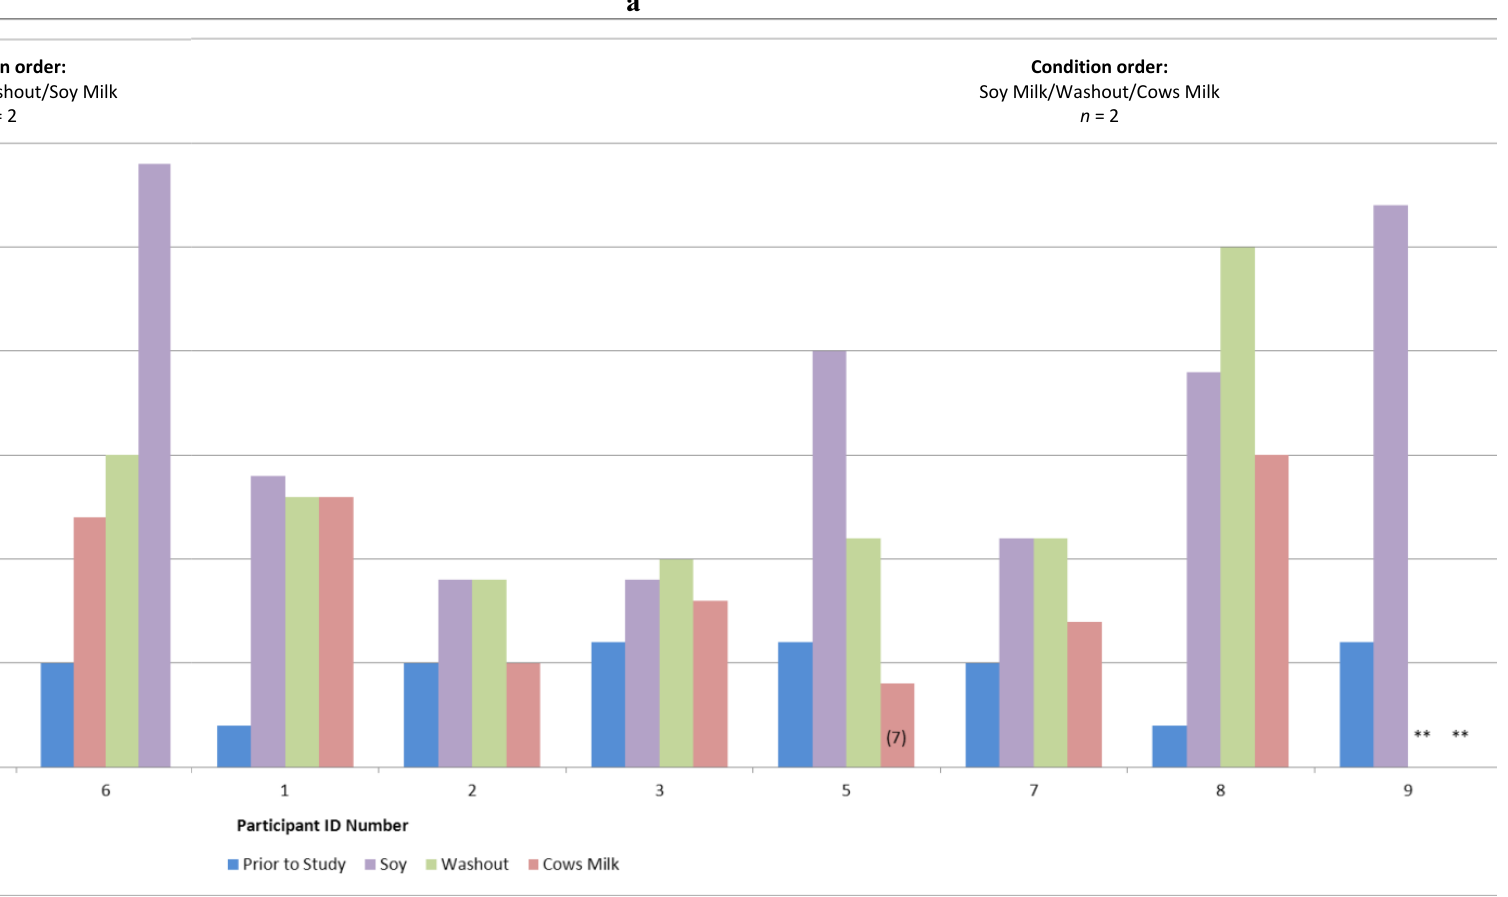
Figure 3. ( a ) Number of stools per fortnight at baseline and on each of the study conditions for Trial 1; ( b ) Number of stools per fortnight at baseline and on each of the study conditions for Trial